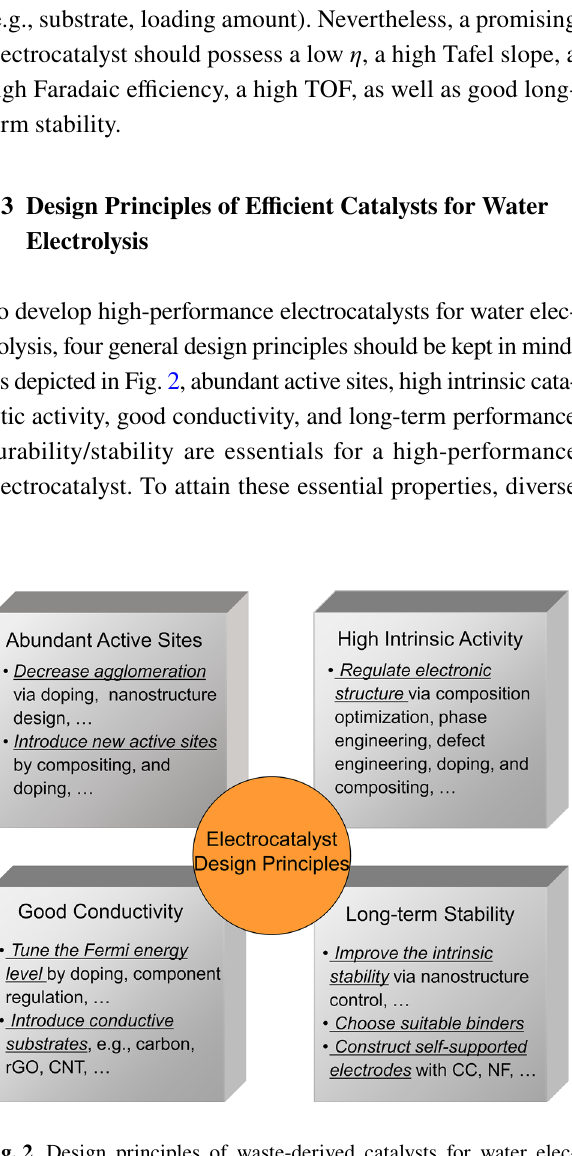
Fig. 2 Design principles of waste‑derived catalysts for water elec‑